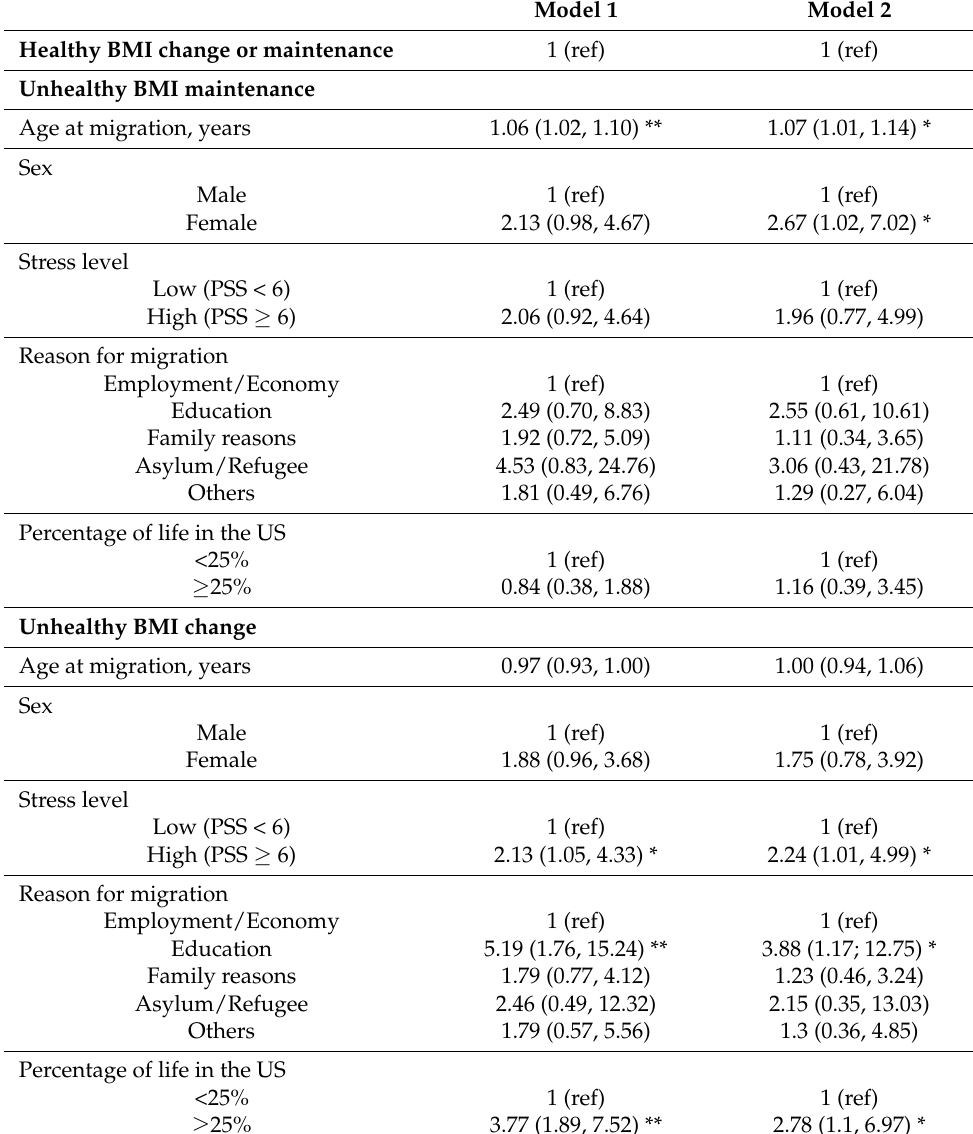
Table 2. Unadjusted and adjusted multinomial logistic regression of factors associated with body mass index change among African immigrants to the US. N =